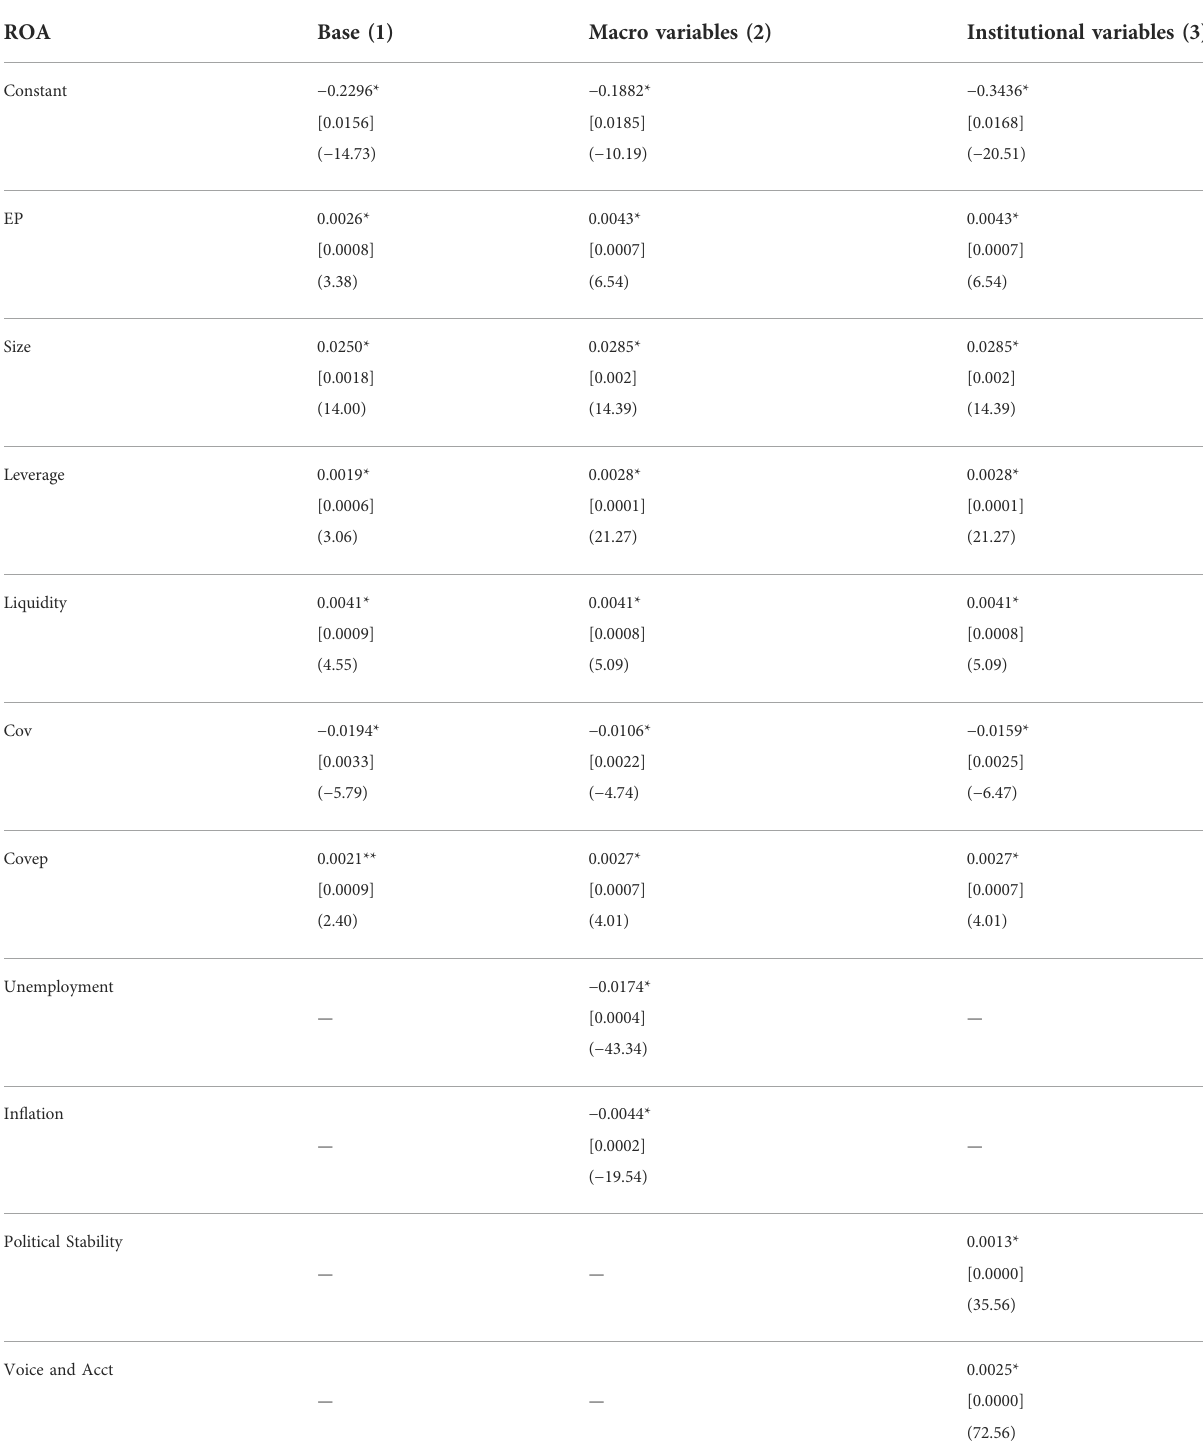
TABLE 2 Determinants of fi nancial performance